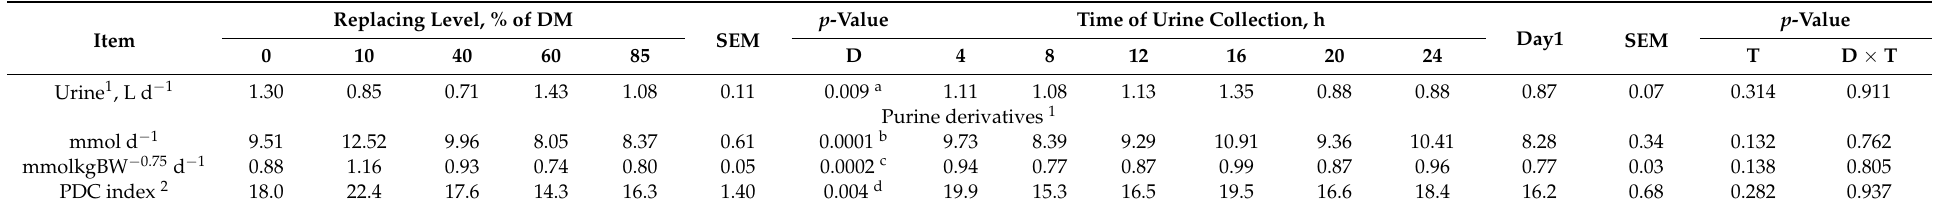
Table 4. Estimated urine volume, excretion of purine derivatives (PD) and PD/creatinine index using the first day (day 1) of 24-h total urine collection and urine spot samples collected at 4-h intervals of time (T) after morning feeding in lambs fed diets (D) containing peach palm meal replacing